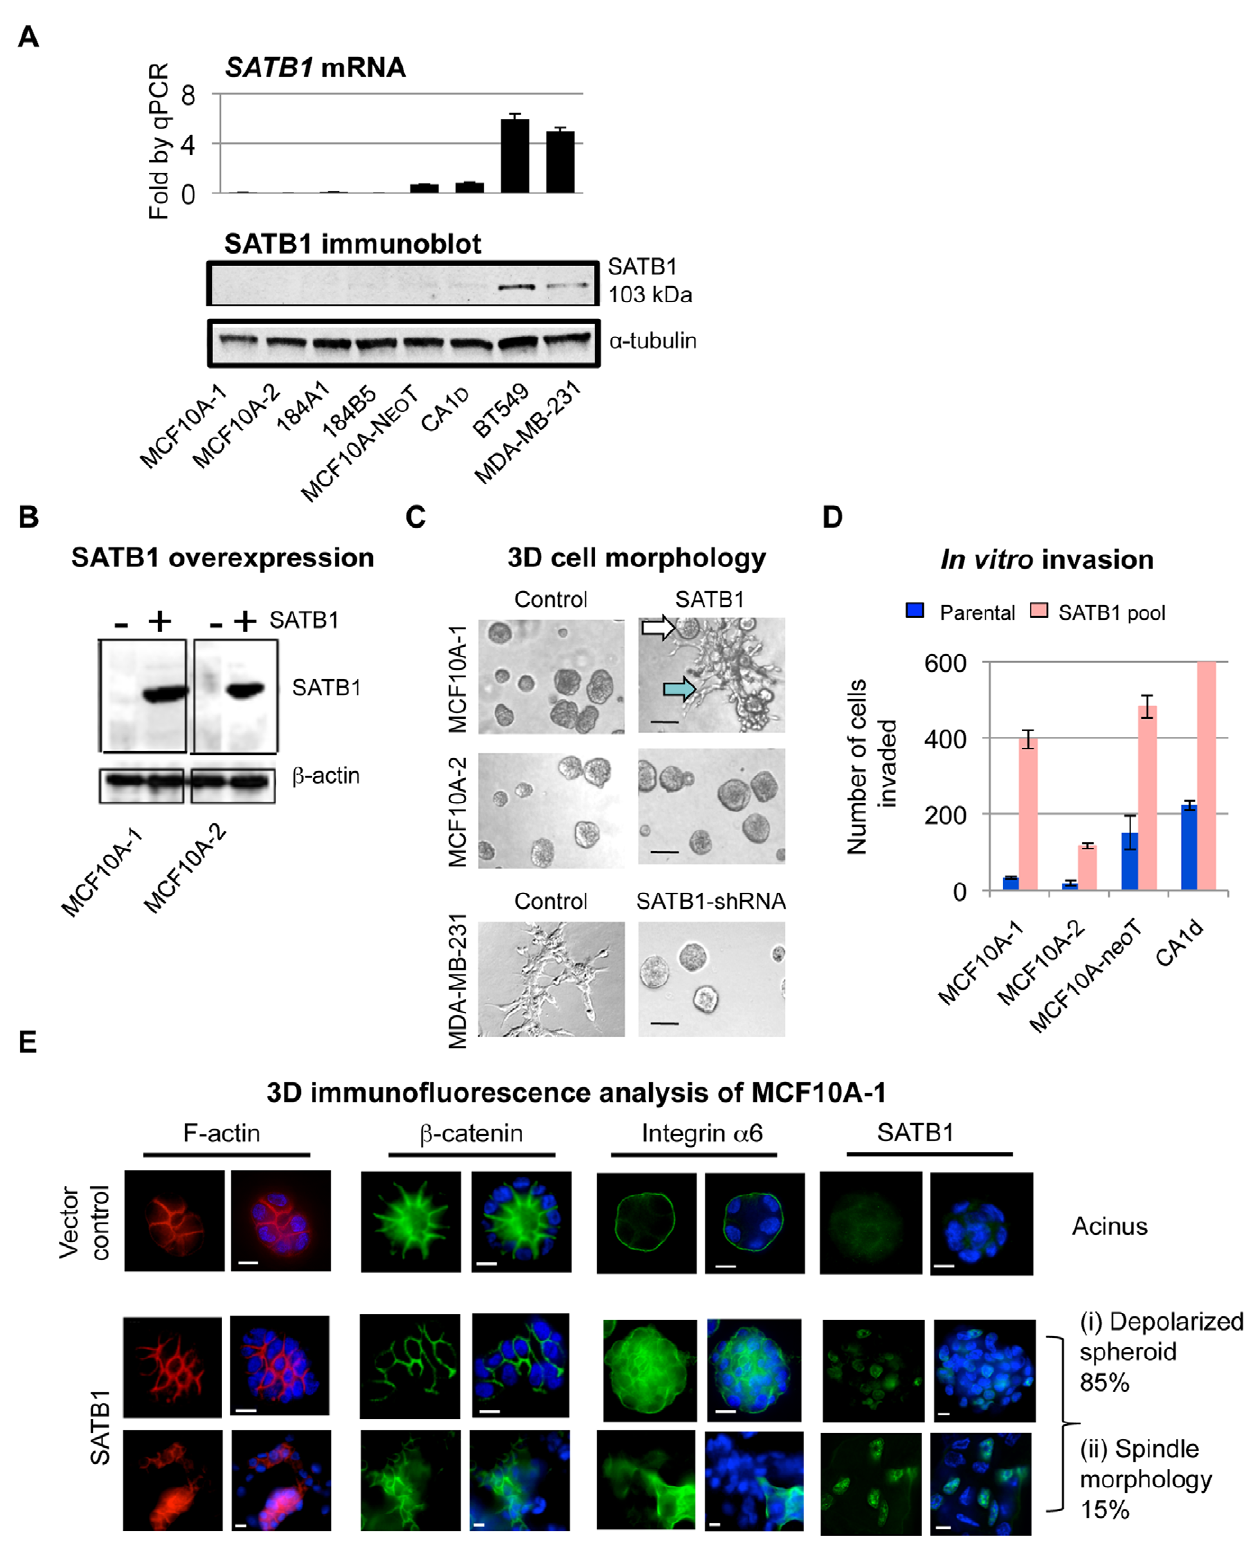
Figure 1. SATB1 is endogenously expressed in aggressive breast cancer cell lines and its ectopic expression induces malignant phenotype in non-malignant MCF10A-1, but not in MCF10A-2 cells. A ) (Top) Quantitative RT-PCR analysis for SATB1 expression relative to GAPDH in MCF10A cell lines from two different sources (MCF10A-1 and MCF10A-2), 184A1, 184B5 and MCF10A progression series (MCF10A-neoT and CA1d), BT549 and MDA-MB-231. (Bottom) Immunoblot for SATB1 expression using the same cell lines as in quantitative RT-PCR analysis. a -tubulin was used as an internal loading control. B ) Immunoblot showing the expression level of SATB1 before and after SATB1 overexpression in MCF10A-1